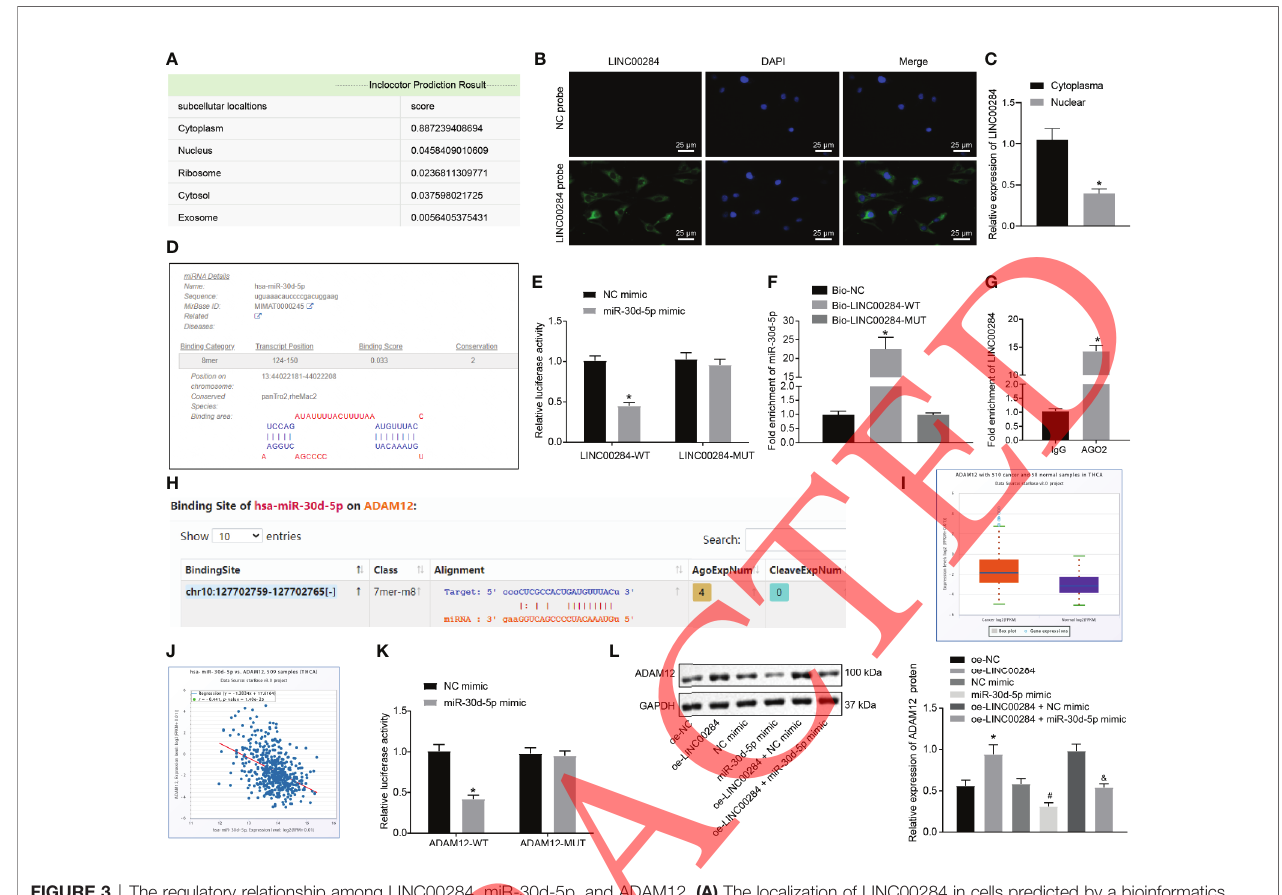
FIGURE 3 | The regulatory relationship among LINC00284, miR-30d-5p, and ADAM12. (A) The localization of LINC00284 in cells predicted by a bioinformatics website. (B) The localization of LINC00284 in HTh74 cells detected using the FISH assay. (C) The localization of LINC00284 in HTh74 cells detected using RT- qPCR, * p < 0.05 compared with the cytoplasm. (D) The binding sites for LINC00284 and miR-30d-5p analyzed using the miRDB website. (E) The binding relationship between LINC00284 and miR-30d-5p was identi fi ed by conducting a dual-luciferase reporter assay, * p < 0.05 compared with cells transfected with the NC mimic. (F) The relationship between LINC00284 and miR-30d-5p was detected using an RNA pull-down assay, * p < 0.05 compared with cells transfected with Bio-NC or Bio-LINC00284-MUT. (G) The binding of LINC00284 to the AGO2 protein was detected using a RIP assay, * p < 0.05 compared with cells binding to IgG. (H) The binding sites for miR-30d-5p and ADAM12 predicted by the TargetScan website. (I) ADAM12 expression in thyroid cancer samples in the TCGA database; the red box indicates tumor samples, and the purple box indicates normal samples (FDR = 1.1e-7). (J) Correlation analysis of miR-30d-5p and ADAM12 expression in the TCGA database. The correlation coef fi cient and correlation p value are shown in the upper left of the panel. (K) The binding relationship between miR-30d-5p and ADAM12 was veri fi ed by dual-luciferase reporter assay, * p < 0.05 compared with cells transfected with the NC mimic. (L) Western blot analysis of ADAM12 protein expression in C643 thyroid cancer cells after the overexpression of LINC00284 or miR-30d-5p. * p < 0.05 compared with cells transfected with oe-NC, # p < 0.05 compared with cells transfected with the miR-30d-5p mimic, & p < 0.05 compared with cells transfected with oe-LINC00284 + NC mimic. Data are presented as the means ± standard deviations. Comparisons between two groups were analyzed using unpaired t -tests, and comparisons among multiple groups were analyzed using one-way ANOVA, followed by Tukey ’ s post hoc test. The experiments were repeated three